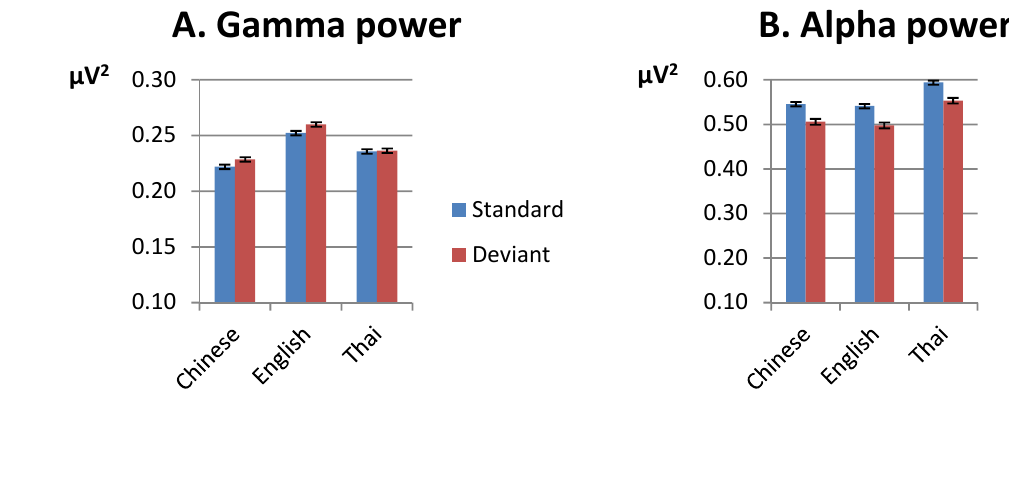
Figure 1. Means over all lateral electrodes for the three language groups before training, collapsed over tone. ( A ) gamma-band power, 200–400 ms after stimulus onset; ( B ) alpha-band power, 100–500 ms after stimulus onset; ( C ) gamma-band phase synchrony (PLS) with FCz, 200–400 ms after stimulus onset; ( D ) alpha-band phase synchrony (PLS) with Cz, 100–500 ms after stimulus onset. Note that the y -axis starts at 0.1, and that different scales are used for the different subfigures. The error bars represent the Standard